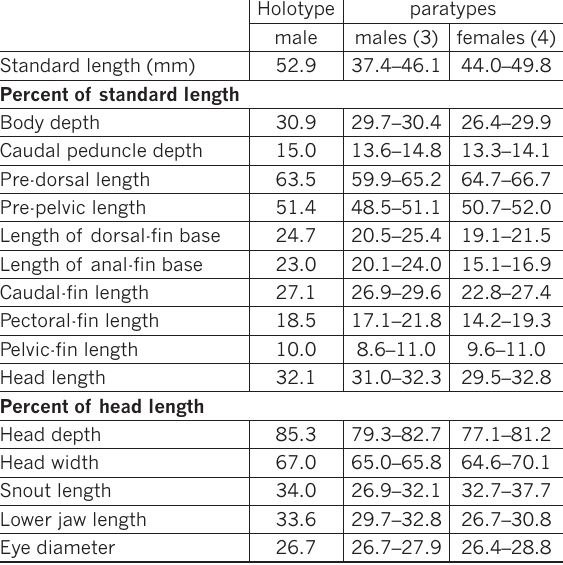
Table 2. Morphometric data of Nothobranchius insularis